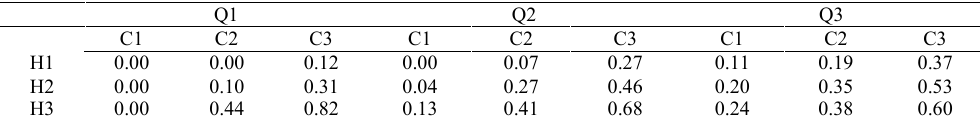
Table 4: Final relative concentration in all the experiments Q1